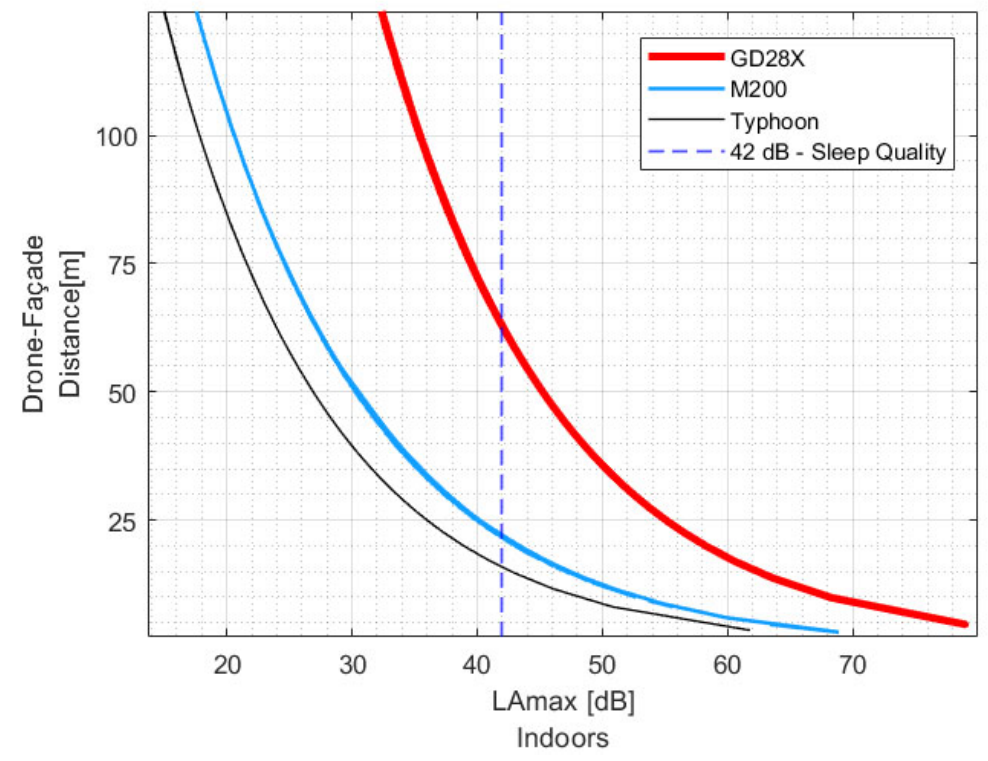
Figure 10. Recommended drone/façade distance based on the LA max , indoors for the tested drones at fast flyover operation near a façade with a conventional window–closed.